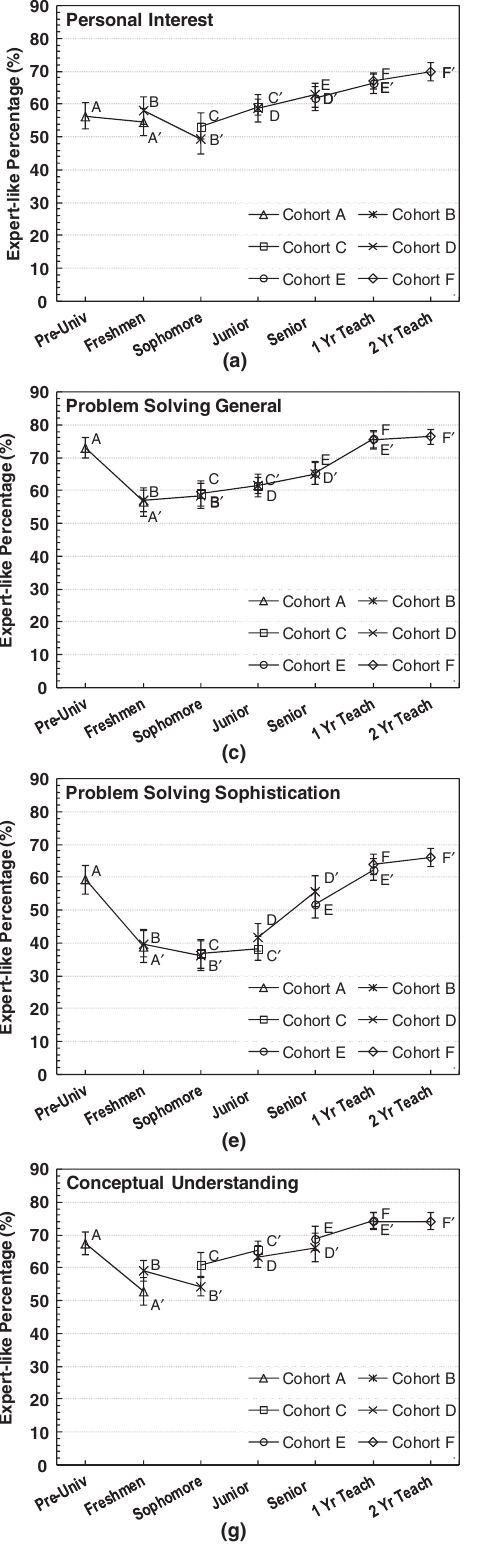
FIG. 3. Sequential trend lines denoting the longitudinal shifts on the 8 categories of CLASS for participants in cohorts A, B, C, D, E, and F. Error bars represent standard errors. (a) Personal interest, (b) real-world connection, (c) problem solving general, (d) problem solving confidence, (e) problem solving sophistication, (f) sense making, (g) conceptual understanding, and (h) applied conceptual